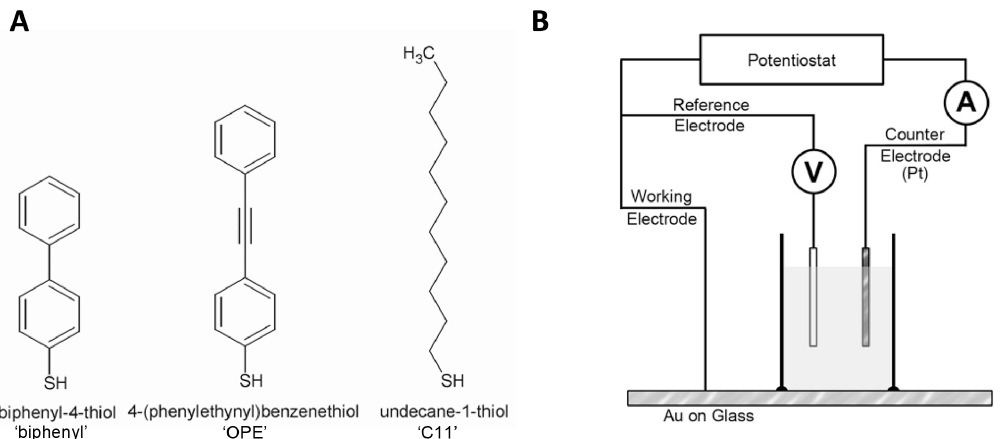
Fig. 1. Experimental details. A. Chemical structures for biphenyl-4-thiol (Biphenyl), 4-(phenylethynyl)benzenethiol (OPE) and undecane-1-thiol (C11) used to from SAMs on gold electrodes. B. The electrochemical